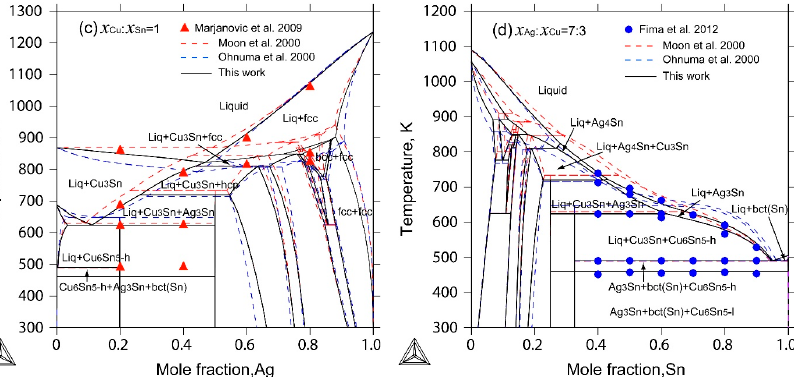
Figure 5. Calculated vertical sections of the Ag-Cu-Sn ternary system with the experimental data from [26,27] and the calculated results from [21,24]. ( a ) 𝑥 (cid:3002)(cid:3034) :𝑥 (cid:3004)(cid:3048) = 1 ; ( b ) 𝑥 (cid:3002)(cid:3034) :𝑥 (cid:3020)(cid:3041) = 1 ; ( c ) 𝑥 (cid:3004)(cid:3048) :𝑥 (cid:3020)(cid:3041) = 1 ; ( d ) 𝑥 (cid:3002)(cid:3034) :𝑥 (cid:3004)(cid:3048) = 7:3 .